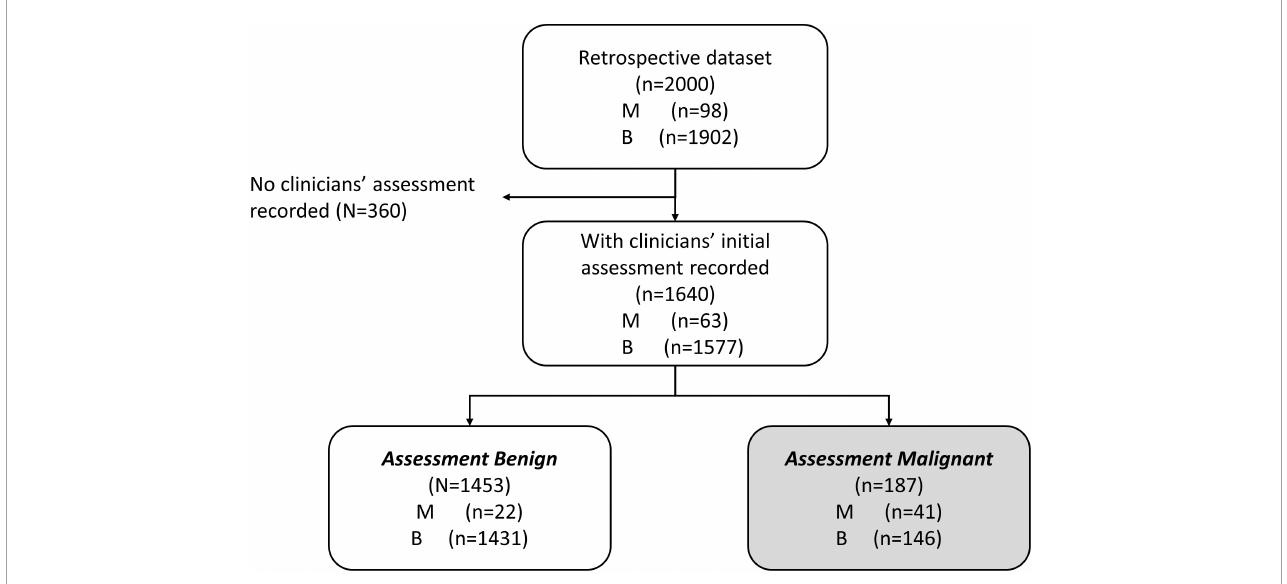
FIGURE1 Work-flow diagram showing analysis data set stratified by physician assessment of malignancy risk. A comprehensive retrospective validation was performed on 2,000 samples with 98 malignant and 1,902 benign specimens [citation]. Within these data, 1,640 received an independent physician clinical assessment–using imaging and other clinical examination–as either benign or malignant. A total of 1,453 patients were independently assessed as benign by physician, prior to surgery (MIAB data set).